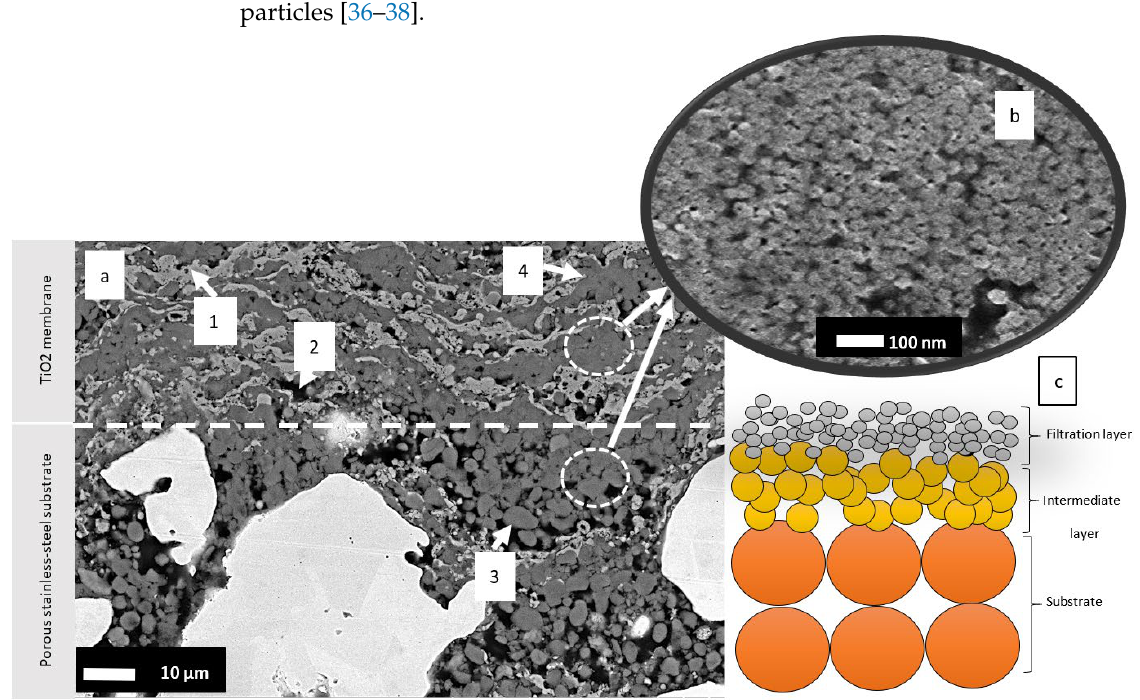
Figure 6. ( a ) SEM micrograph of M-8 inside the large pores of the substrate and close to the surface of the substrate, including 1: melted splats (light gray), 2: large pores (black), 3: loosely packed unmelted nanostructured agglomerates (dark gray), and 4: tightly packed unmelted nanostructured agglomerates (dark gray). ( b ) High-magnification SEM micrograph of the microstructure in the dark gray areas, and ( c ) schematic of the asymmetric microstructure of ceramic membranes.